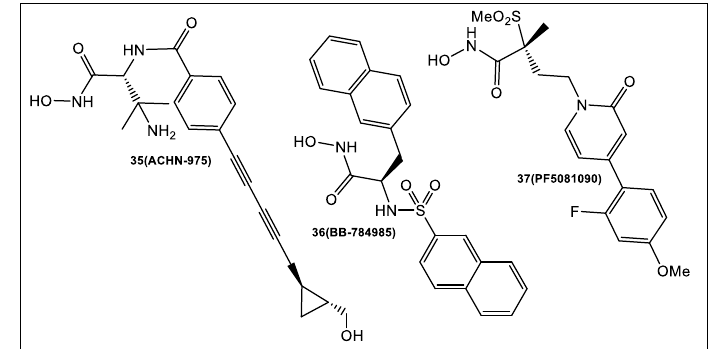
Figure 6. Representatives of hydroxamate-based advanced LpxC inhibitors.